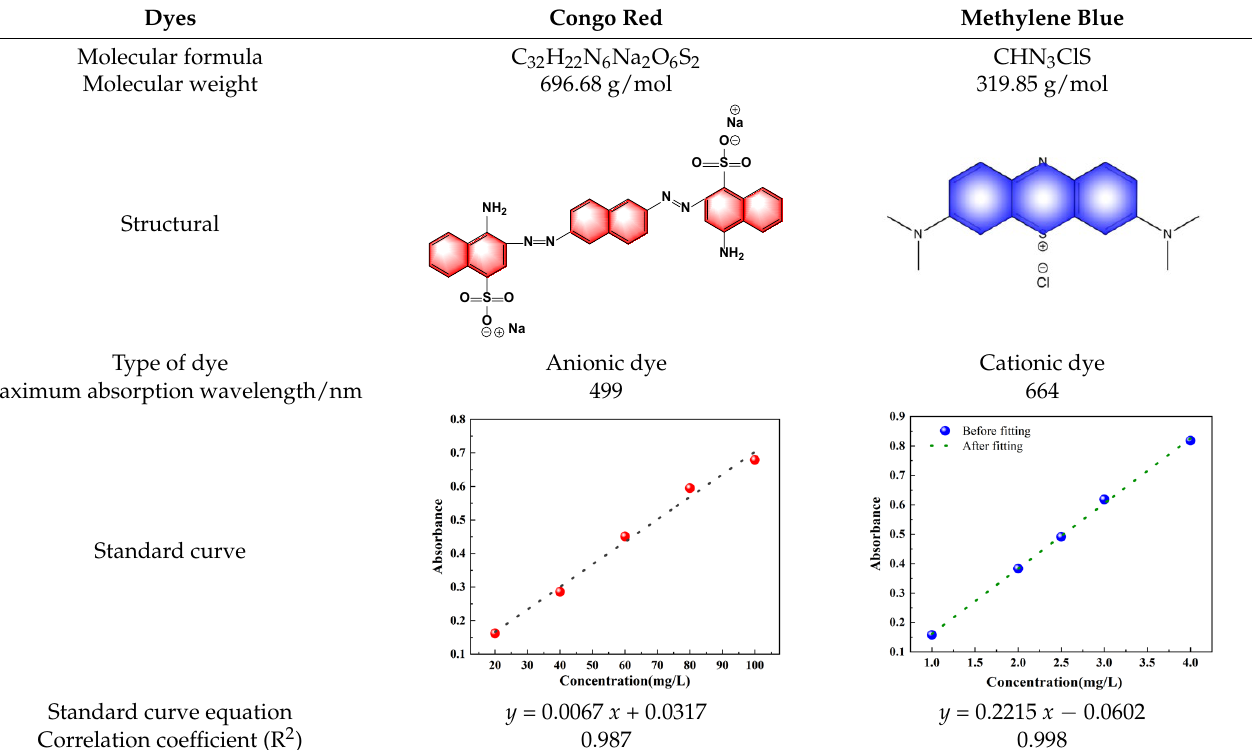
Table 2. Basic parameters and fitting standard curve equation of two organic dyes.